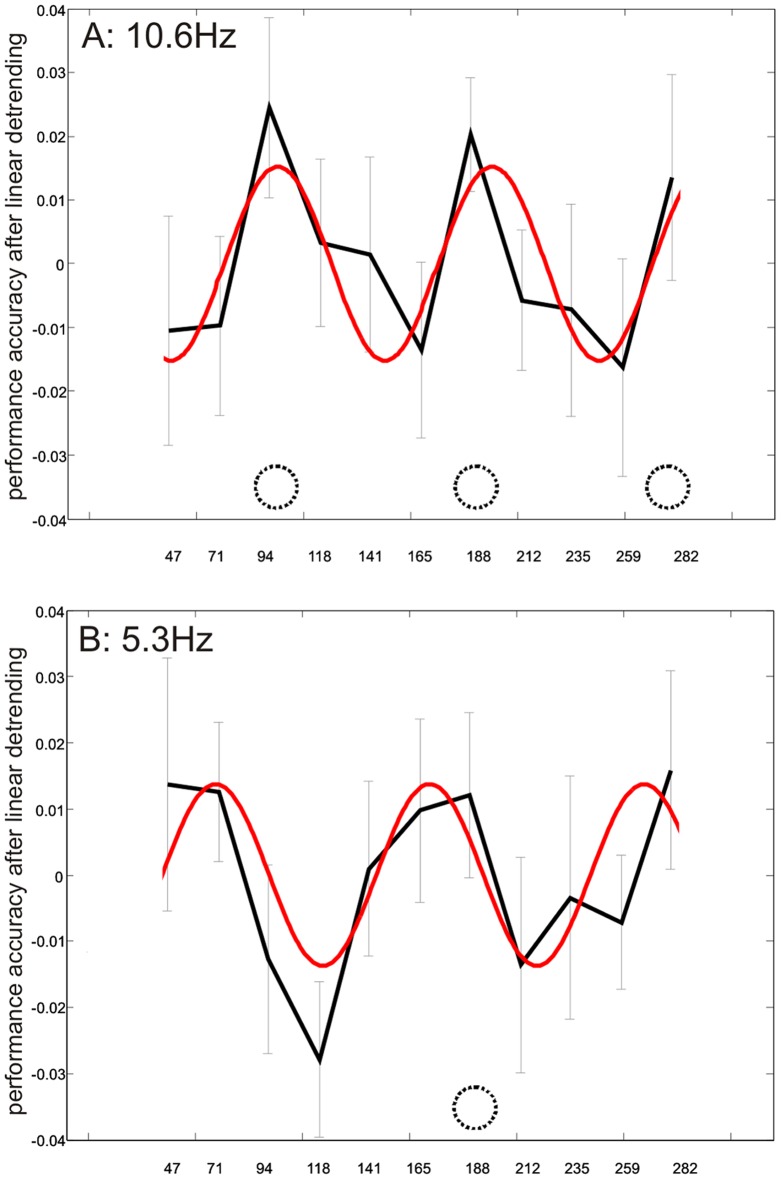
Results Experiment 2.Group averaged accuracy (linearly detrended) for target discrimination at congruent locations over 3 alpha cycles post-train following A) 10.6 Hz- or B) 5.3 Hz-cueing. The best fitting 10 Hz model cosines are superimposed. For both 10.6 Hz and 5.3 Hz (subharmonic) congruent cueing, we found recurrent peaks and troughs which were significantly fitted by a 10 Hz cosine function. Thus, a cyclic pattern at alpha-frequency is apparent in visual task performance. Error bars reflect standard error of the mean after removal of baseline between-subject variance (within-subject error bars: [49]).